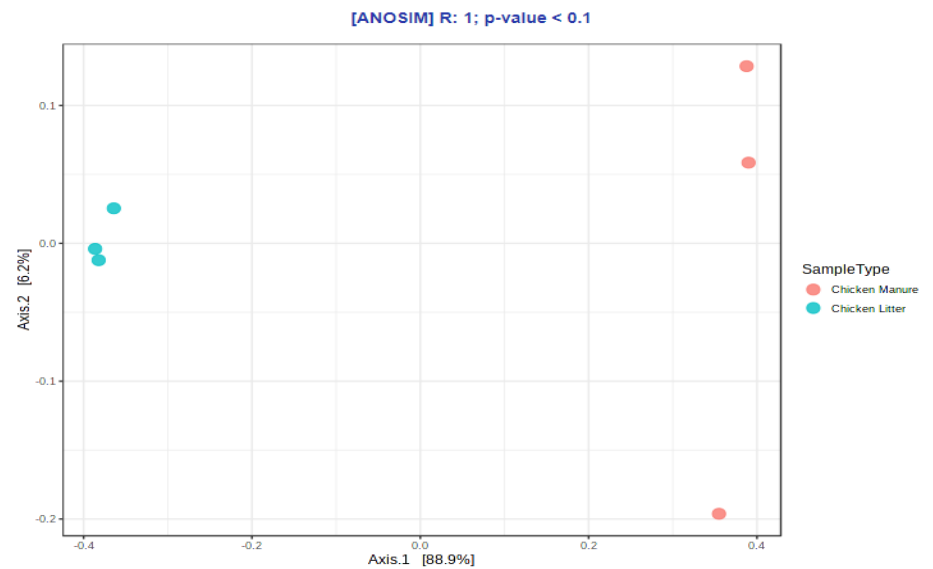
Figure 6. Principal coordinate analysis (PCoA) of ARG and MGE compositions in collected chicken waste samples based on Bray–Curtis dissimilarity matrices (chicken manure: CM_1, CM_2, CM_3 (orange dots), and chicken litter: CL_1, CL_2, CL_3 (blue dots)).